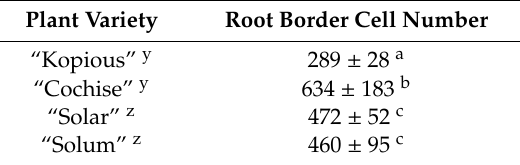
Values represent the mean ± standard deviation from at least three replicate samples in at least three independent experiments ( n ≥ 9). Cell numbers with the same letter are not significantly different according to Welch Two Sample t-test ( p < 0.01).